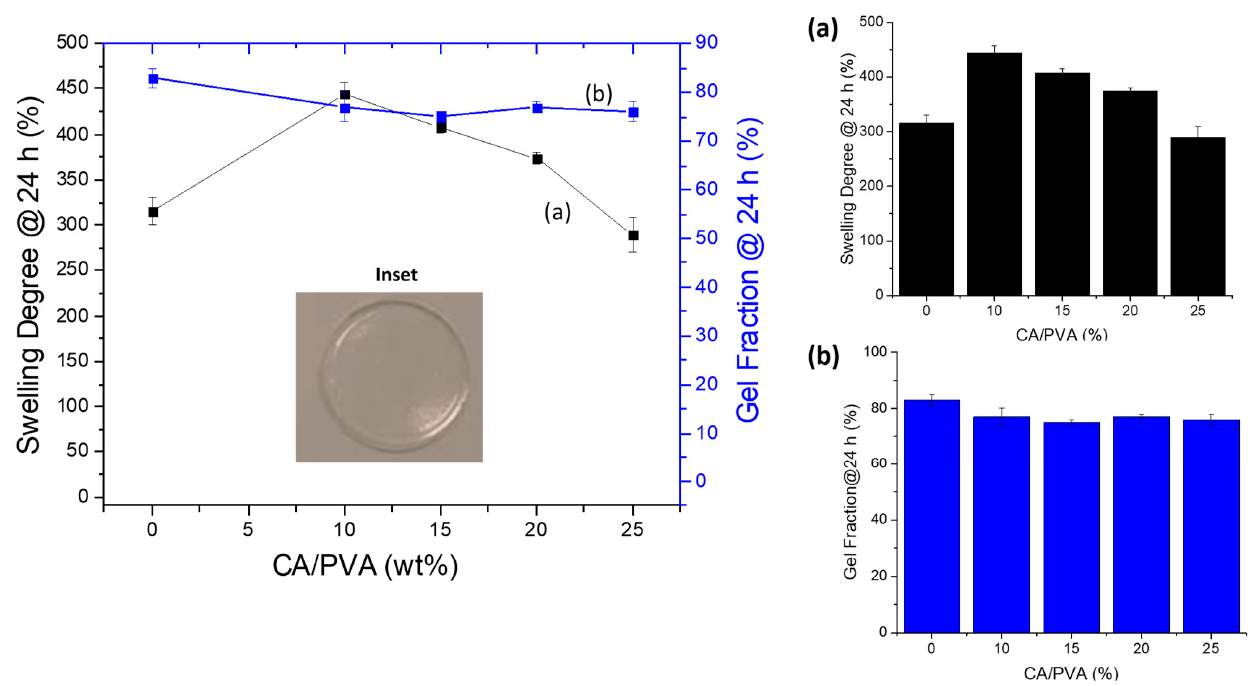
Figure 5. Swelling degree ( a ) and gel fraction ( b ) properties of hydrogels of PVA crosslinked with citric acid (inset: digital image of PVA_CA25).